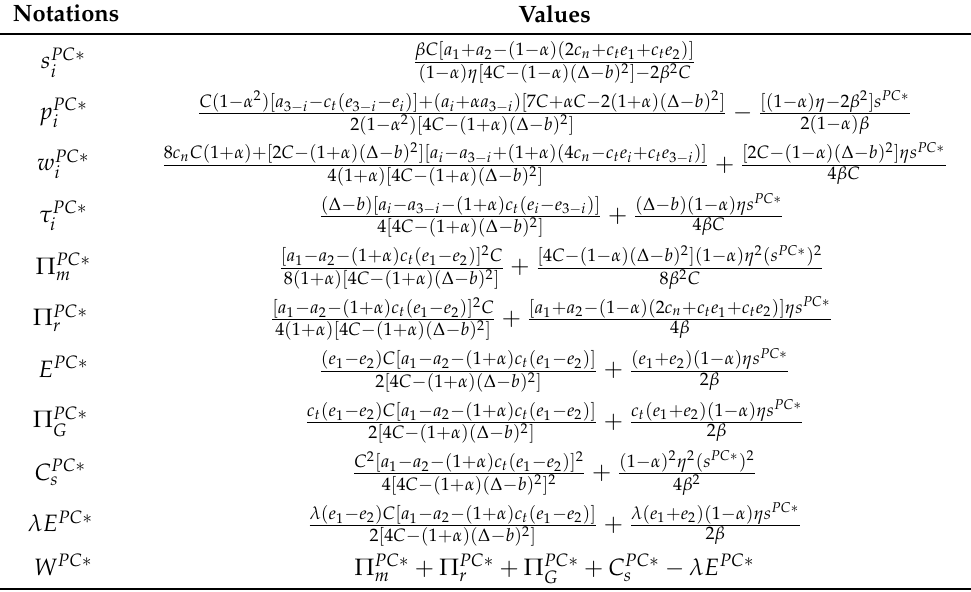
Table 5. Main results for the partial cooperation model of retailer with green marketing, i = 1, 2. Notations